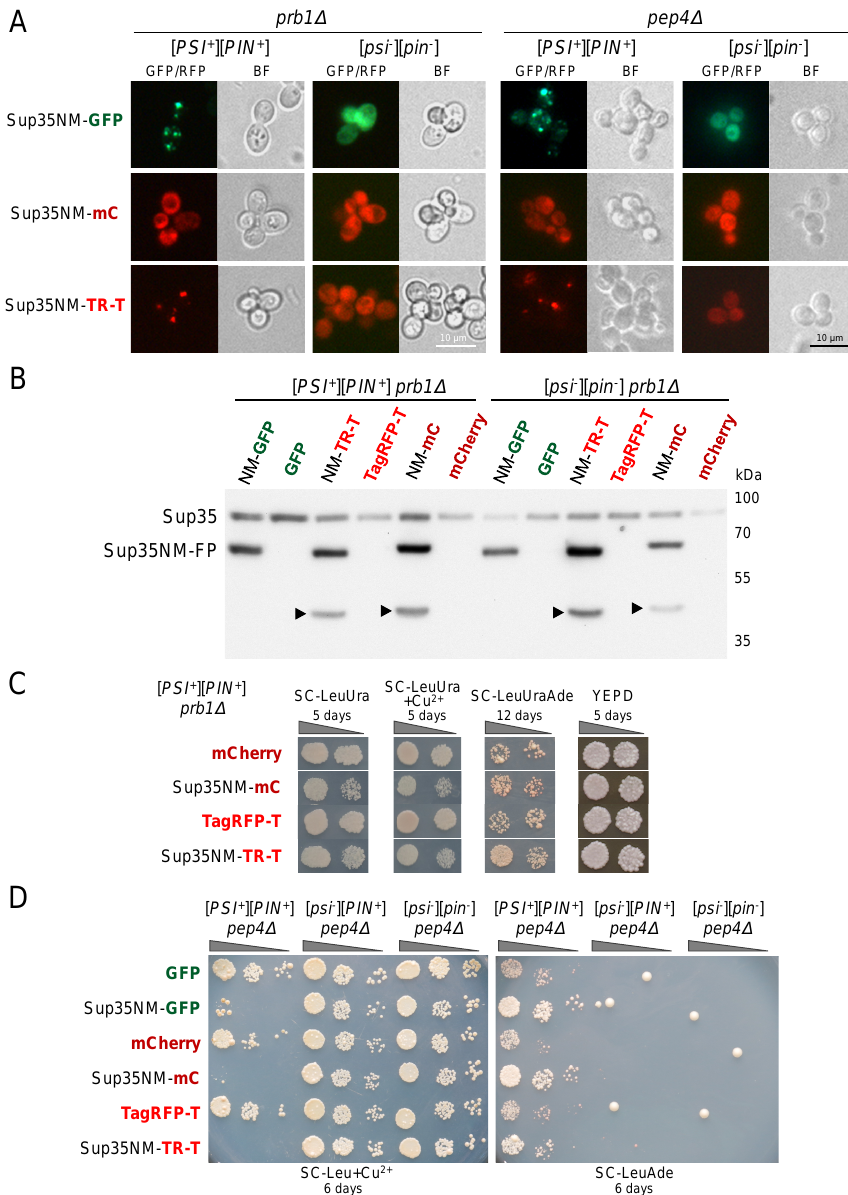
Figure 5. Vacuolar proteases do not influence Sup35NM-mCherry properties. ( A ). Fluorescent images of the prb1 ∆ or pep4 ∆ cells overexpressing SUP35NM fused to different fluorescent protein genes. ( B ). Western blot analysis of protein lysates from prb1 ∆ strains overproducing the indicated proteins. Arrowheads indicate major additional products detected by anti-Sup35NM antibodies. ( C ). Tenfold serial dilutions of the prb1 ∆ 0-P-74-D694 strain co-transformed either with pRS315 together with pIM35 (TagRFP-T) or pR16CUP-NM-yTagRFP-T (Sup35NM-TR-T), or with pRS316 together with pRS315CmC (mCherry) or pRS315CNMmC (Sup35NM-mC). The panels for each medium are taken from the same plate. ( D ). Tenfold serial dilutions of the pep4 ∆ strains transformed with plasmids for expression of the indicated